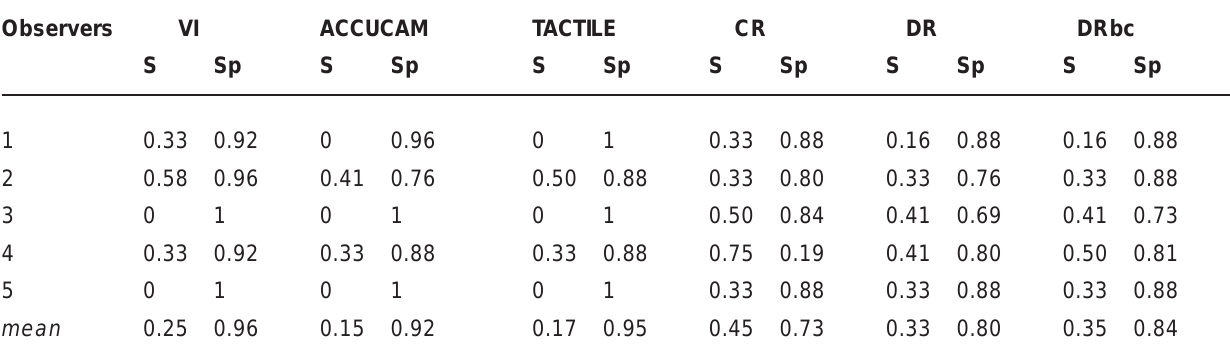
TABLE 1 - Sensitivity (S) and specificity (Sp) values and mean of the diagnostic methods, visual inspection (VI), visual inspection and blunt-tipped exploratory probes (Tactile), endoscopic evaluation (AccuCam), conventional bite-wing (CR), direct bite-wing digital radiography (DR) and direct digital radiography with contrast and brightness control (DRbc) obtained Observers